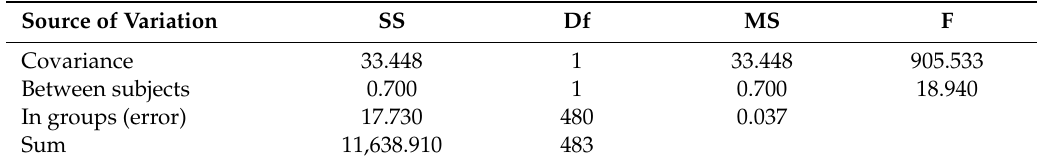
Table 7. Left eye visual acuity ANCOVA results.